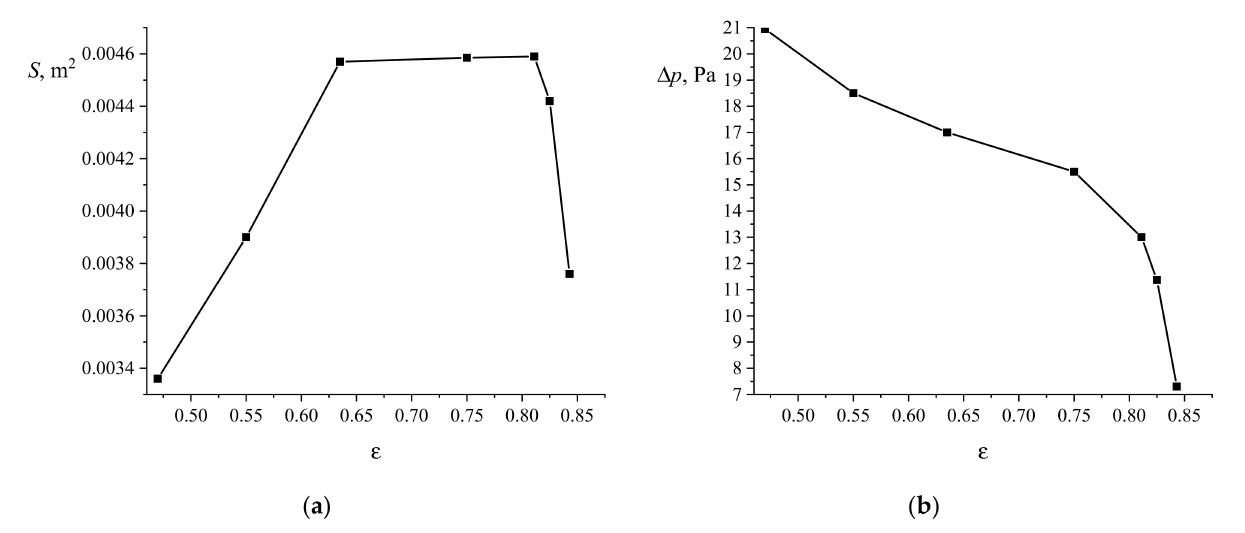
Figure 9. The parameters of the granular bed depend on the flow rate: ( a ) bed area; ( b ) pressure